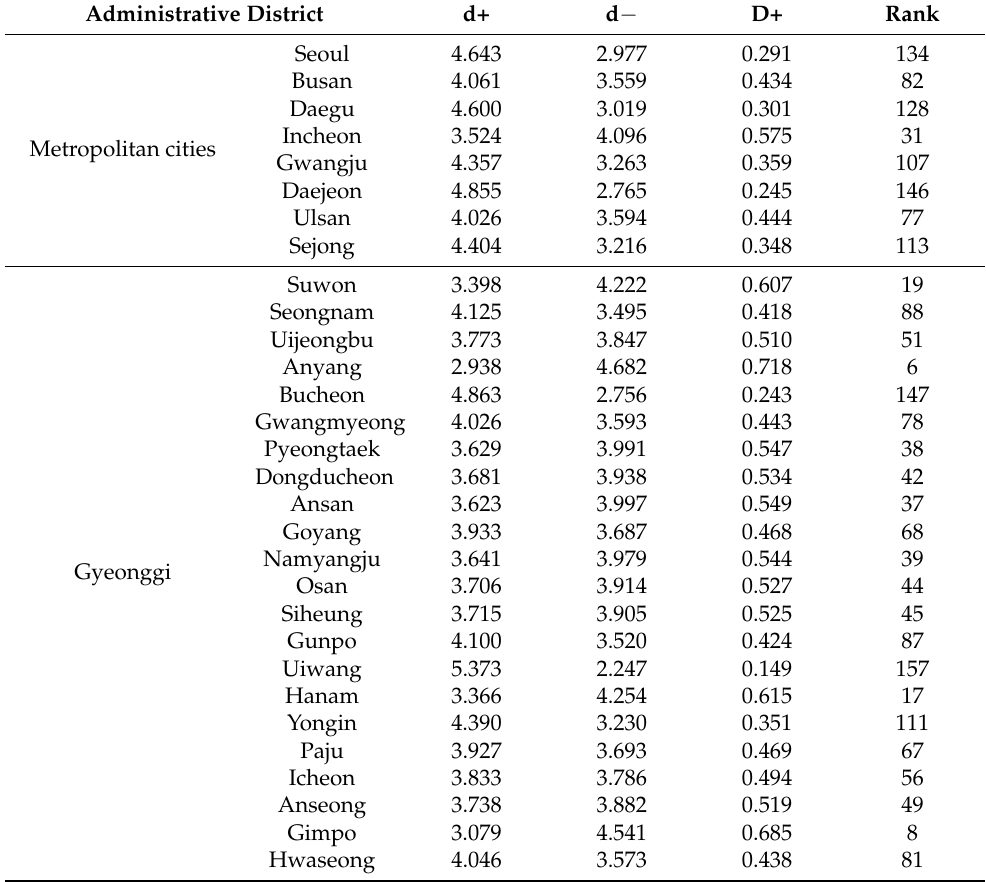
Table 3. Results of the TOPSIS analysis.